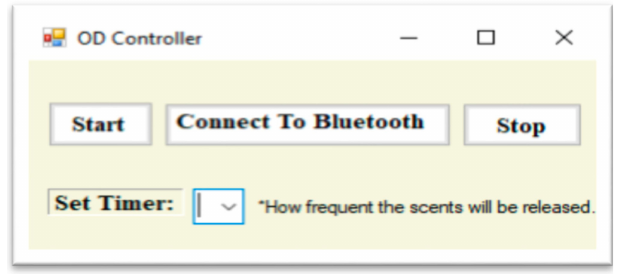
Figure 5. Screenshot of Windows